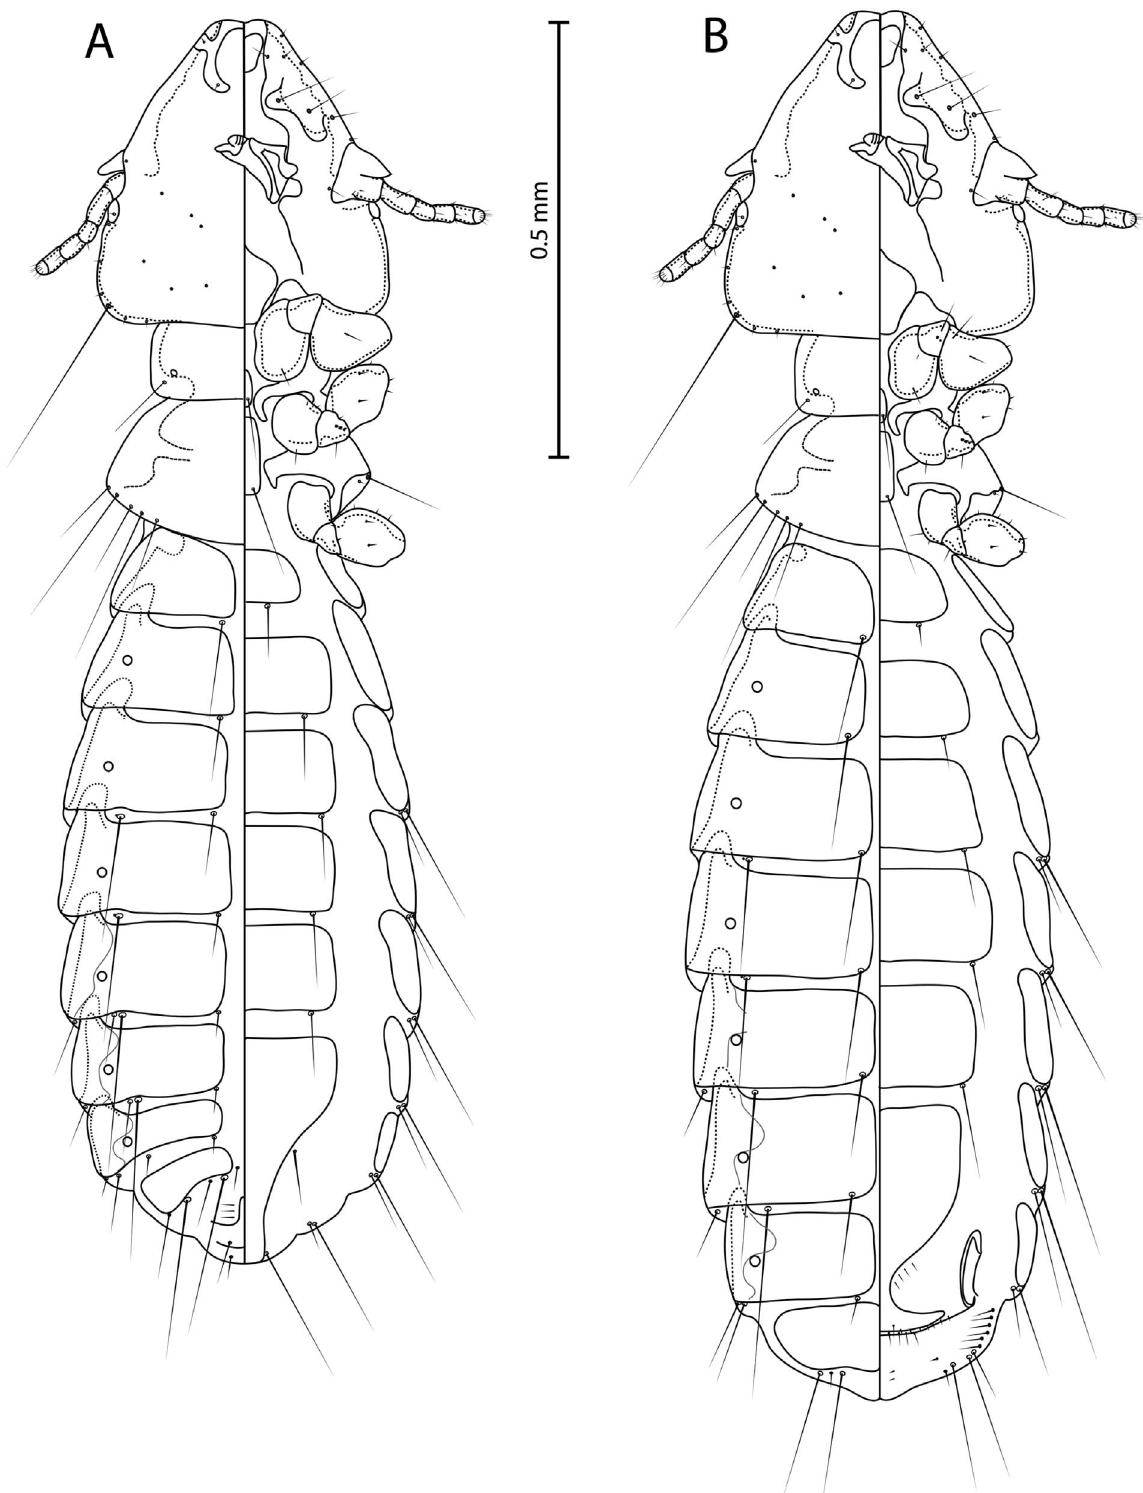
Figure 1. Guimaraesiella tovornikae ex Sylvia atricapilla . (A) Male dorso-ventral view; (B) Female dorso-ventral